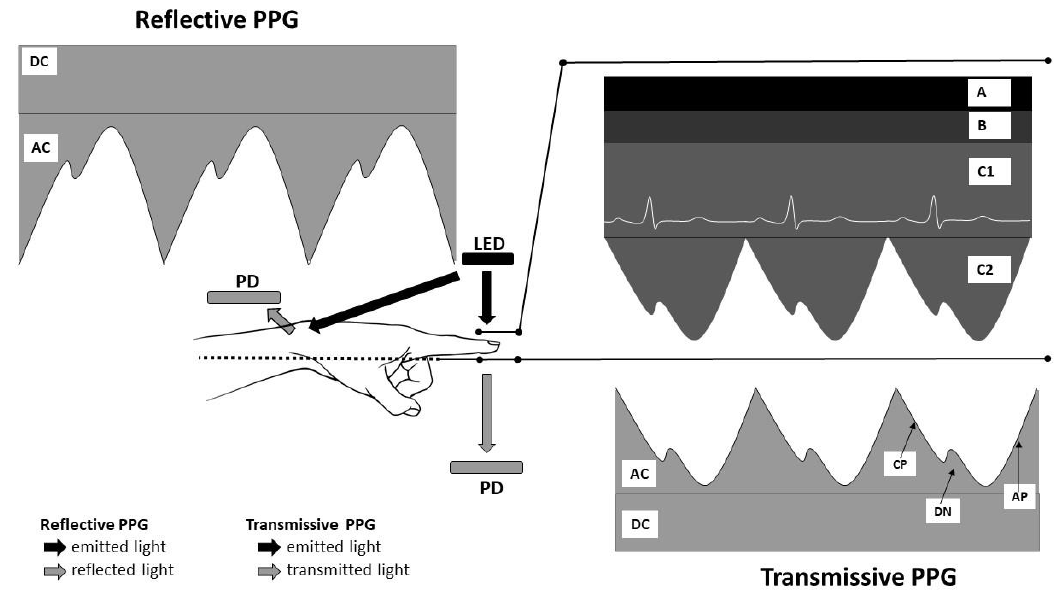
Figure 1. Basis of photoplethysmography (PPG) signal acquisition. LED: light-emitting diodes; PD: photodetector; A: other tissues; B: venous blood; C1: non-pulsatile component of artery blood; C2: pulsatile component of artery blood; AC: alternating current-the pulsatile part of the PPG waveform; DC: direct current—the steady part of the PPG waveform; AP: anacrotic phase; CP: catacrotic phase; DN: dicrotic notch.